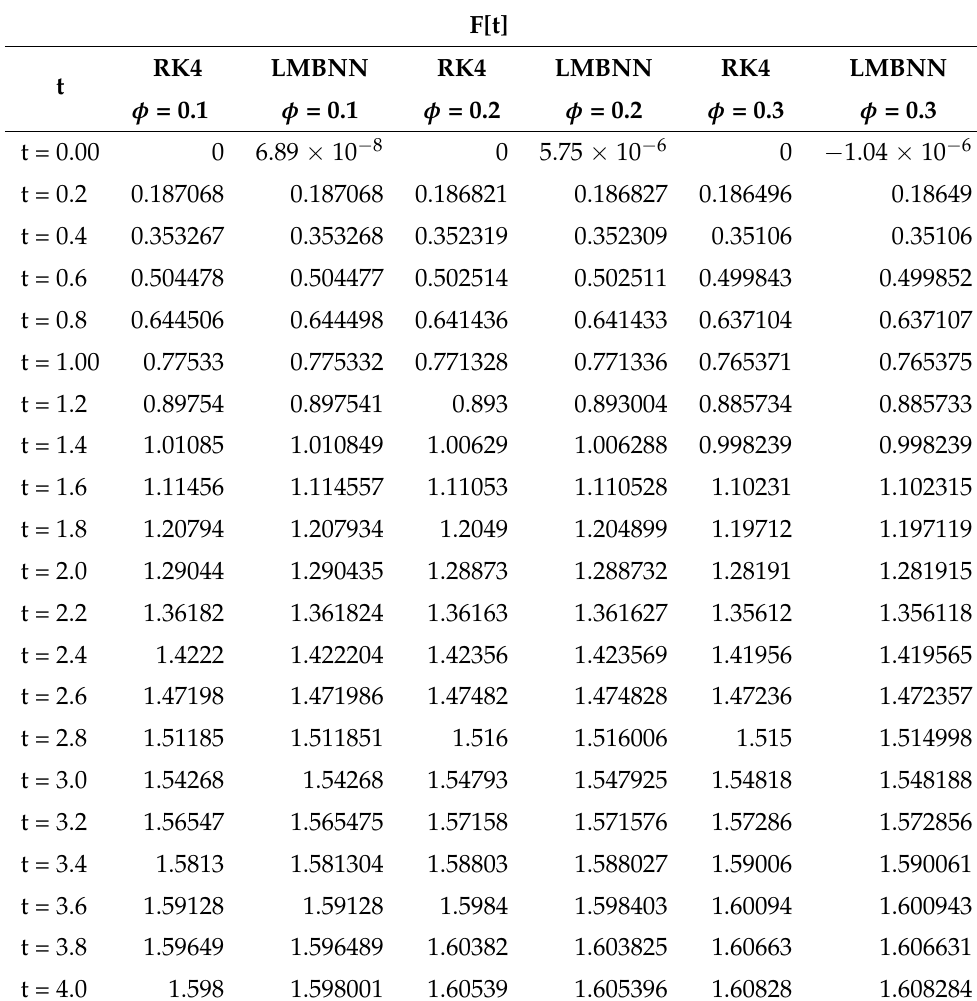
Table 11. Numerical values of F obtained through RK4 and LMBNN using different values of volume fraction φ .